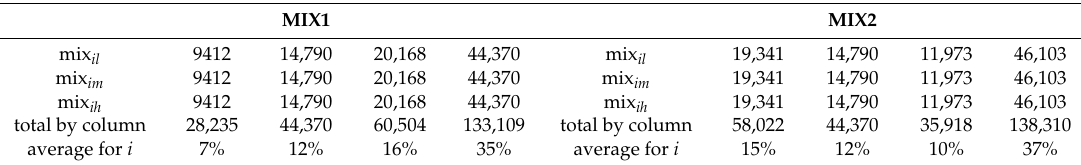
Table A12. Loss in turnover in monetary units with dental charges constant for the 9 mixes under consideration in the two mix scenarios (MIX1 and MIX2). The total value appears in red in Table A12.